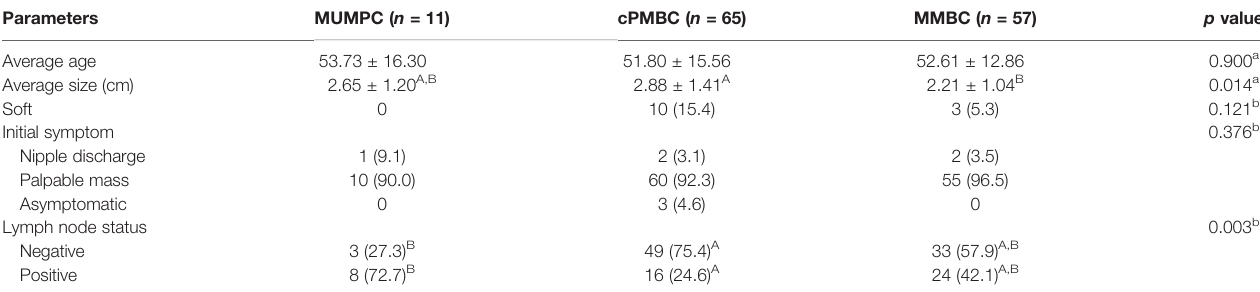
TABLE 1 | Clinical characteristics of MUMPC, cPMBC and MMBC.